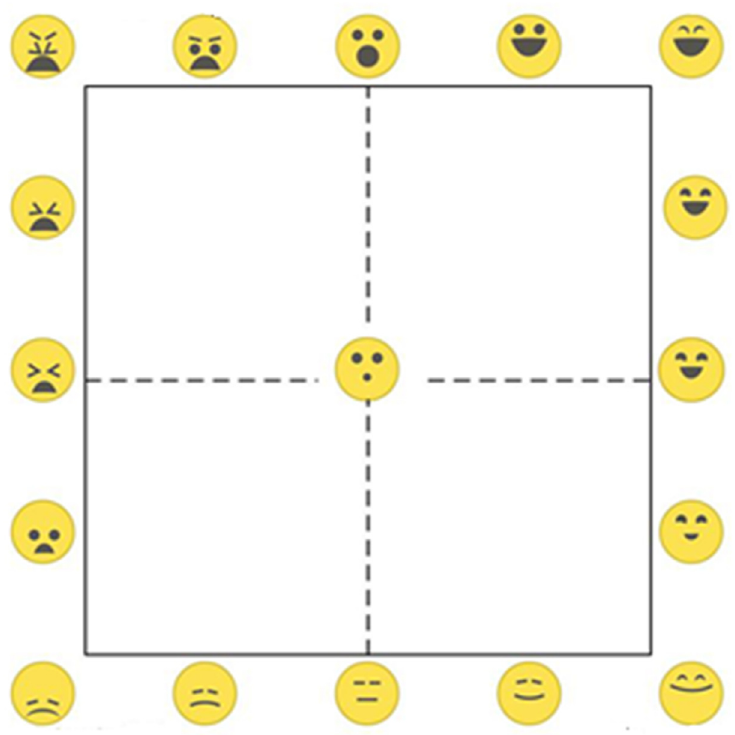
Figure 1. The EmojiGrid. The iconic facial expressions range from disliking (unpleasant) via neutral to liking (pleasant) along the horizontal (valence) axis, while their intensity increases along the vertical (arousal) axis. This figure has been reproduced with permission from Toet et al. , 2018